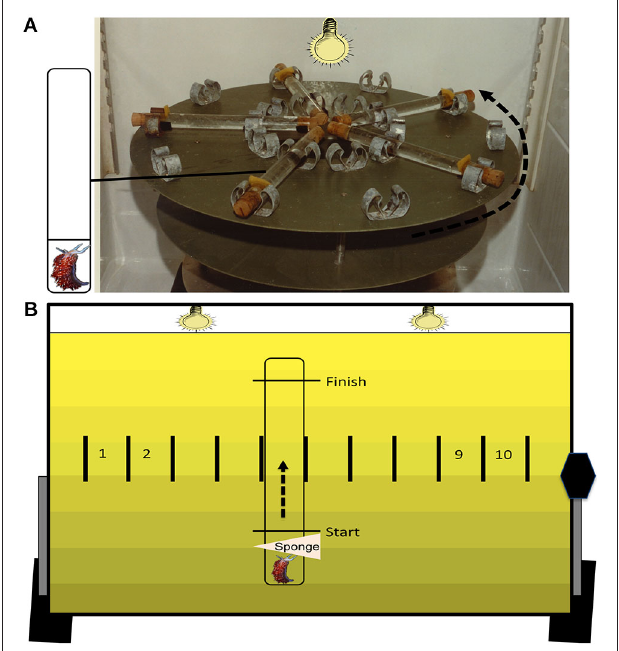
FIGURE 1 | Training and testing apparatus . The training apparatus (A) is a high-speed (100 RPM) turntable. On the surface are 10 pairs of radially arranged clips. Each pair of clips secures one plastic tube that is filled with ASW and corked at both ends. The inset depicts each tube containing two compartments with flow-through holes and one animal that is confined to the small compartment. During associative conditioning, animals are given 50 presentations of simultaneous light (30 s) and rotation (30 s) with a 2 min variable inter-trial interval. The testing apparatus (B) is used to assess phototactic behavior, before and after training. Animals are placed in single-compartment plastic tubes that are filled with ASW. Animals are confined to one end using a sponge stuck into the tube through a small hole. Markings on each tube denote the start and finish line, and each tube is clipped into one of 10 individual testing lanes. During dark adaptation, the surface of the testing table is oriented horizontally. At the start of testing, the table is tilted upright (43 ◦ angle) and the two testing lights are turned on, which results in a gradient of illumination on the testing table (see Section Methods for further details). The sponges are removed, and the latencies to initiate locomotion (start latency) and to cross the distal finish line (finish latency) are recorded for each